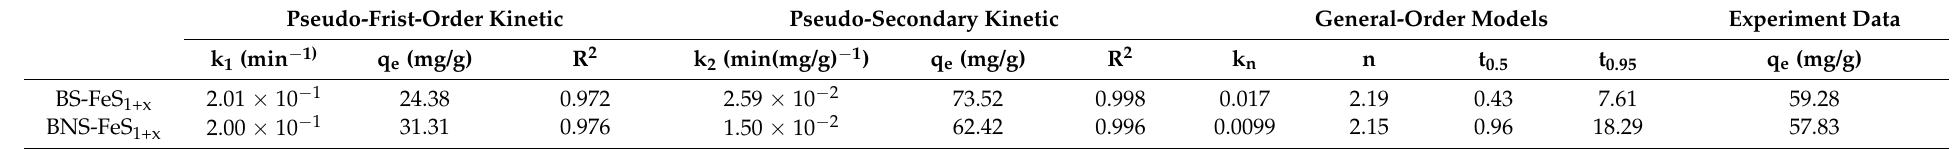
Table 1. Kinetic constants for the removal and adsorption of Cr(VI) using biosynthesis of FeS 1+x